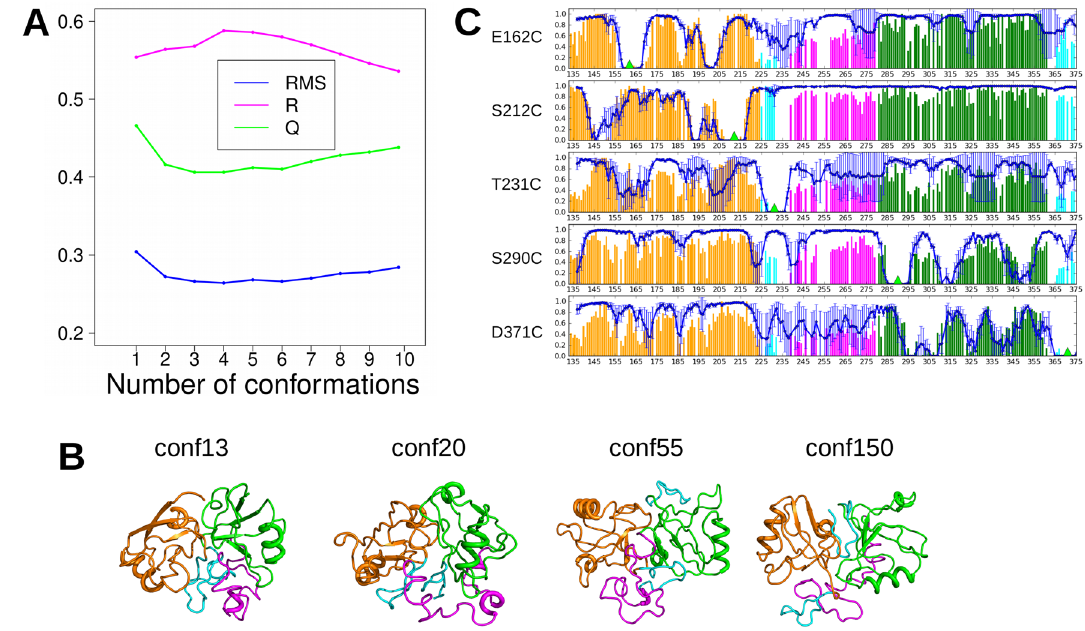
Figure 2. Selection of the P1LnkP2 conformations refined with respect to PRE data. A. Plot of the RMS, R and Q factors in function of the added conformation in the pool of selected closed conformations. The plot was prepared using R 3.4.1 58 . B. Conformations 13, 20, 55 and 150 detected in the group of best four conformations. They are drawn in cartoon with P1 colored in orange, P2 in green, Lnk in magenta and the two hairpins in cyan. The conformations were drawn using pymol 1.8.4.0 59 . C. Comparison of theoretical and experimental PRE profiles for conformations 13, 20 and 55. The theoretical profiles are plotted in blue with error bars and calculated assuming that the three conformations have the same populations. The experimental profiles are drawn as bars, colored with the same color-code than for the protein conformations. Each individual profile plot corresponds to one position of the MTSL probe from top to bottom: E162C, S212C, T231C, S290C, and D371C. The green triangles give the positions of the probe in the sequence. The plot was prepared using python script based on numpy 1.7.1 49 and Matplotlib 1.5.3 60